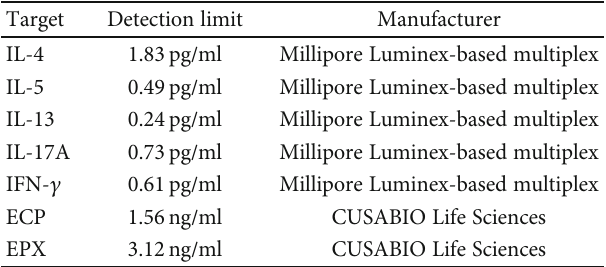
Table 2: Detection limits for cytokine